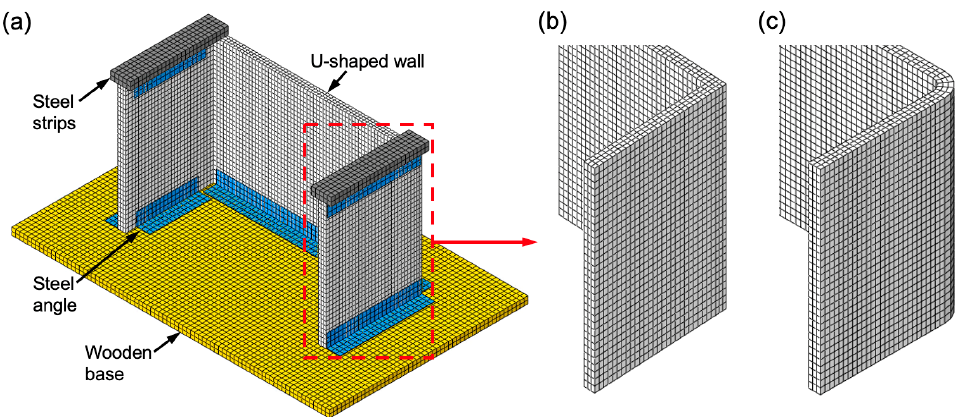
Figure 6. ( a ) Finite-element (FE) mesh of 3D model of U-shaped wall subjected to shaking table testing; ( b ) U-shaped wall with flat corners; and ( c ) U-shaped wall with round corners. Steel parts and wooden base were modelled using densities of 7800 and 500 kg / m 3 ,